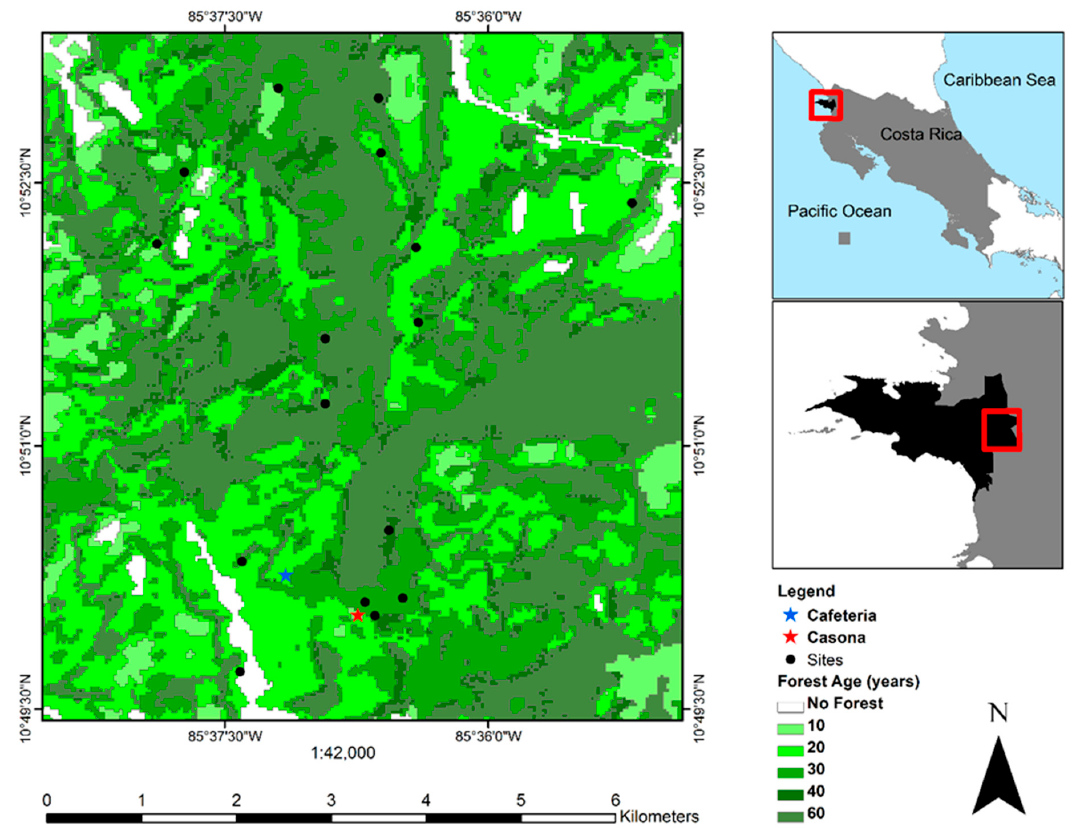
Figure 1. Location of the 16 dry forest study sites at the Sector Santa Rosa within the Area de Conservación Guanacaste (ACG) (black section), Guanacaste, Costa Rica (modified from [29]).